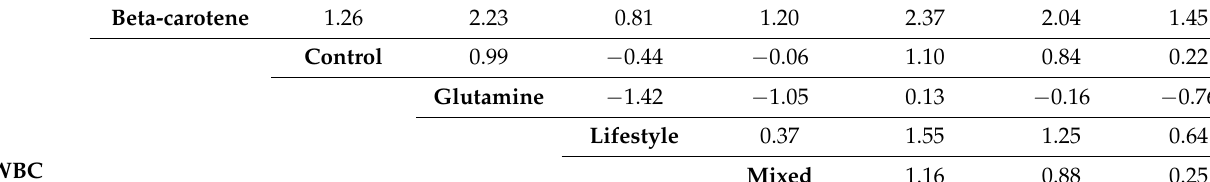
Table 3. The league tables of the network